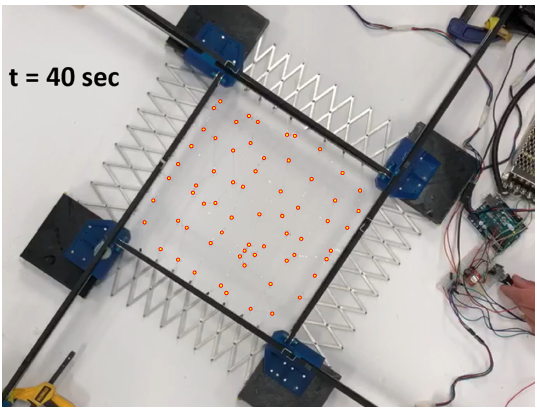
Figure 15. Stretch at 40 s. Red-outlined circles indicate sensor node locations.